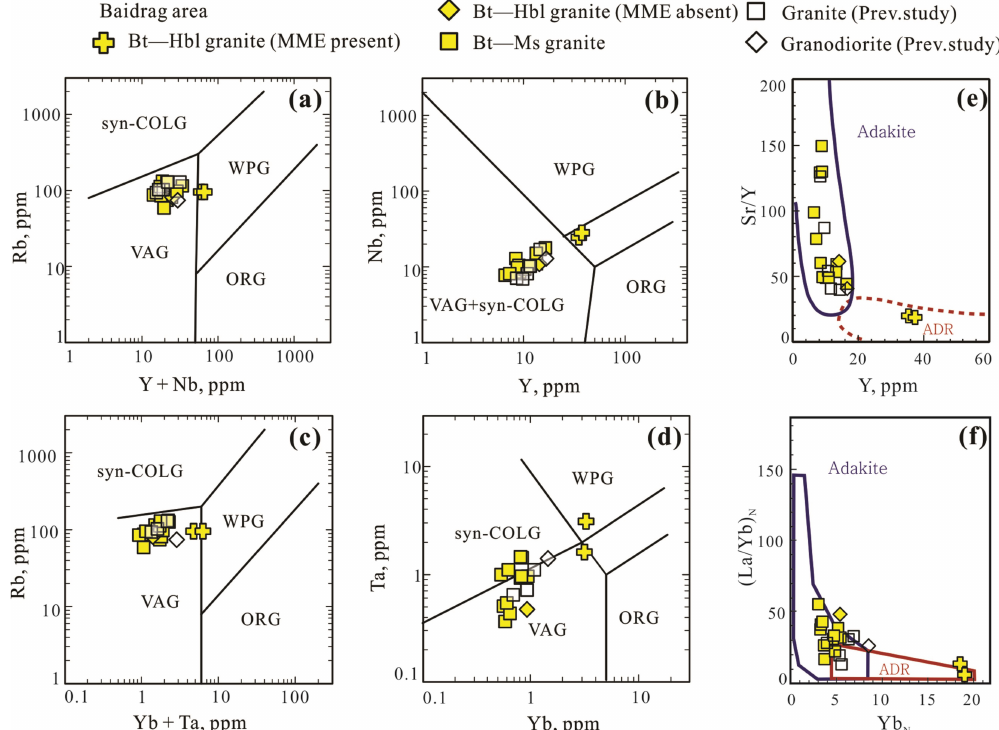
Fig. 6. Diagrams showing granitoids of the Baidrag area plotted on tectonic discrimination diagrams. = volcanic arc granite, COLG = collisional granite, WPG = within plate granite, and ORG = ocean ridge granite; after Pearce et al. (1984). (e–f) Adakite vs. andesite–dacite–rhyolite (ADR) discrimination diagrams of Drummond and Defant (1990) with boundaries of Richards and Kerrich (2007). These diagrams also include previously published data from Buchan et al. (2002), Jahn et al. (2004), and Zhang et al.